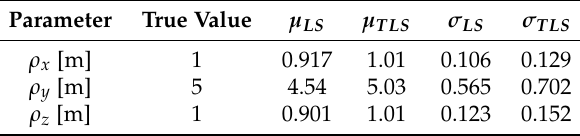
Table 3. Monte-Carlo results summary, 4